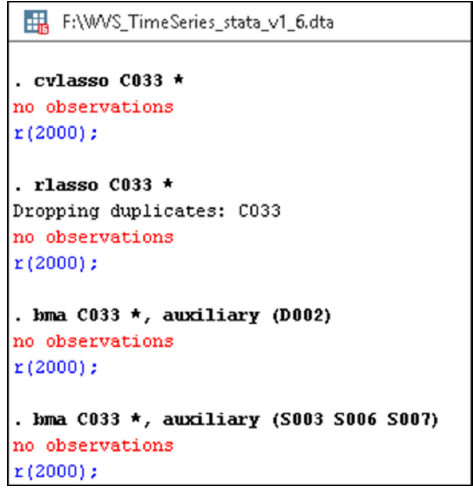
Figure A2. Discovery limitations when using the cvlasso , rlasso , and bma commands in Stata. Note: The same as the first one in Figure 2.